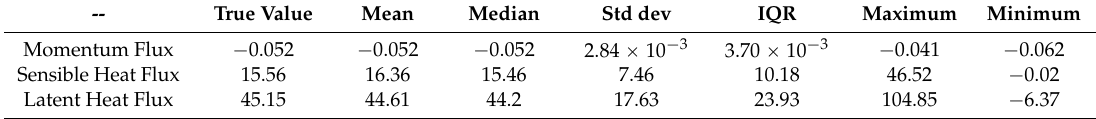
Table 3. Statistical characteristics of the fluxes. The units are the same as in Table 1.